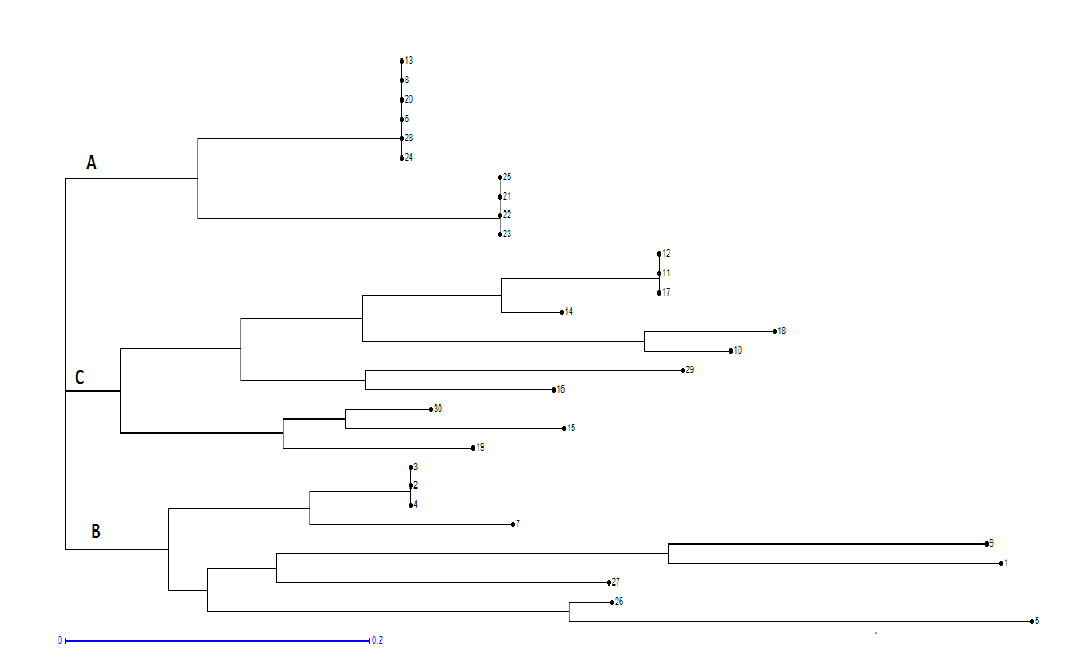
Figure 2. Dendrogram generated by hierarchical clustering method based on unweighted neighbor-joining algorithm and Dice correlation coefficient, showing the genetic similarity among K. pneumoniae isolates by Plasmid Profile Analysis typing